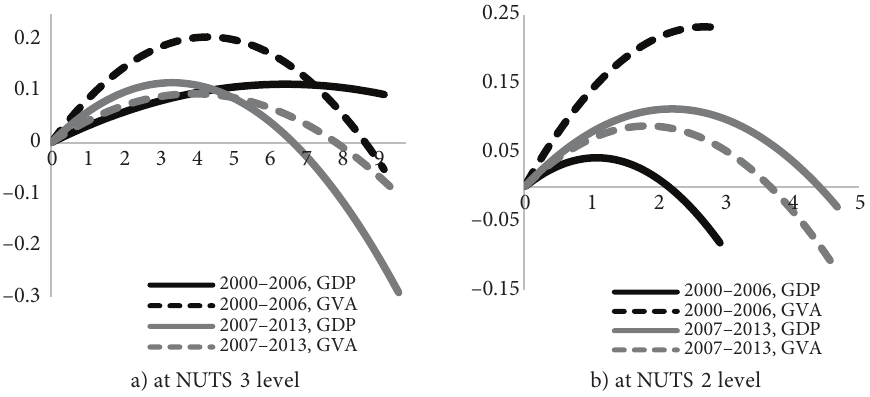
Figure 1. The estimated effect of CP’s transfers’ intensity ( ICP , horizontal axis) on disparities ( ×+× 2 1 2 DiD i DiD i b ICP b ICP , vertical axis)